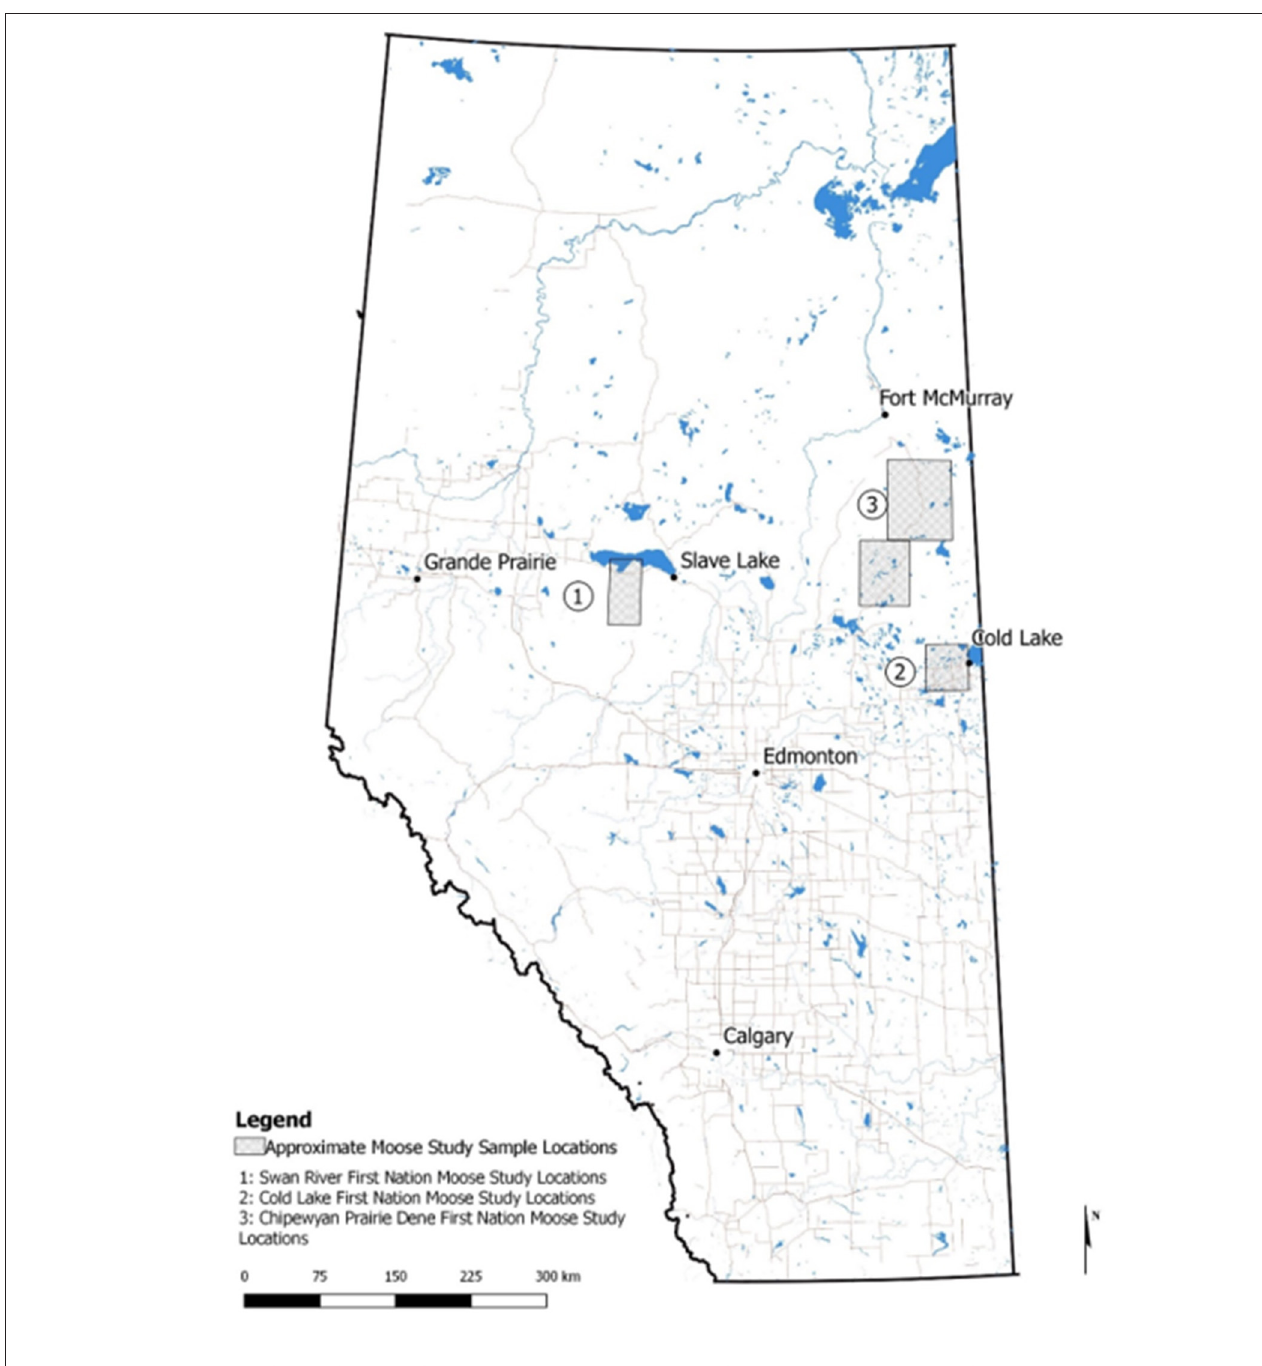
FIGURE 1 | Location